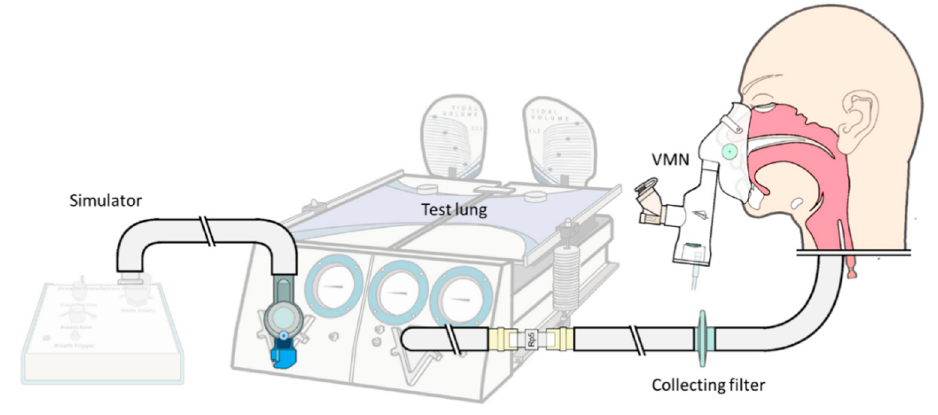
Figure 1. Apparatus of the experimental setup. A simulation module generated negative spontaneous breathing, and a collecting filter distal to the trachea of the mannequin collected aerosolized drug inhaled.